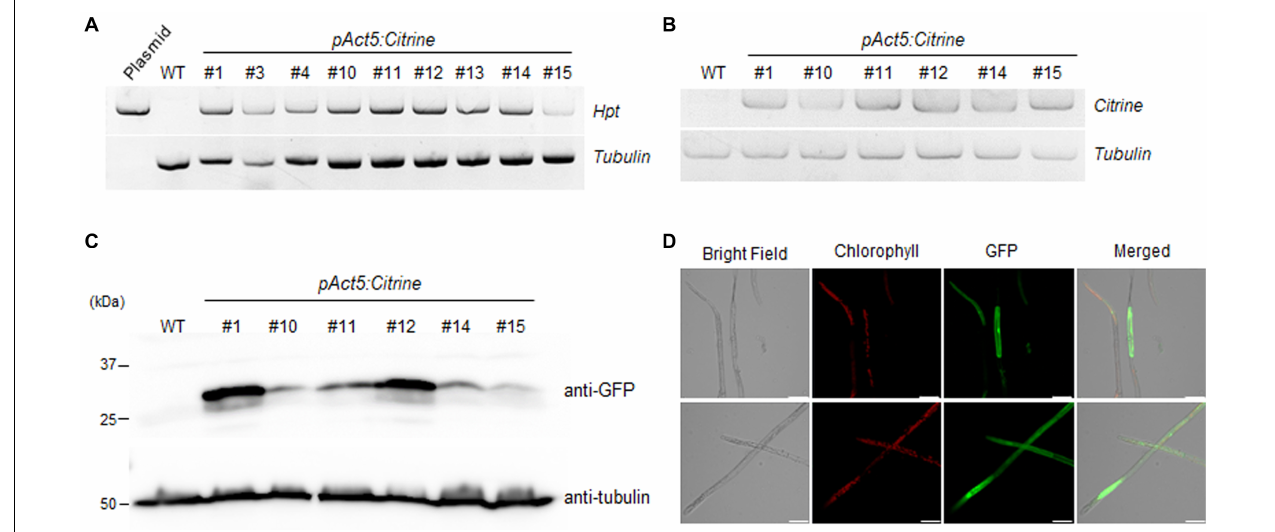
FIGURE 8 | Molecular analysis of pAct5:Citrine transgenic moss. (A) Genomic PCR analysis of transgenic lines and wild-type (WT) moss. Genomic DNA was extracted from protonema cells and used for PCR to amplify the hygromycin phosphotransferase ( hpt ) gene. (B) Reverse transcription (RT)-PCR analysis of Citrine expression in six transgenic lines. Tubulin was used as an internal control. (C) Immunoblot assay. Citrine was detected using anti-GFP antibody. Blot analyzed with anti-tubulin showed equal loading. (D) Confocal microscopy. Expression of fluorescent Citrine protein in pAct5:Citrine line #1 was visualized by confocal microscopy. Fluorescence was excited by a laser at 488 nm. Scale bars = 50 µ